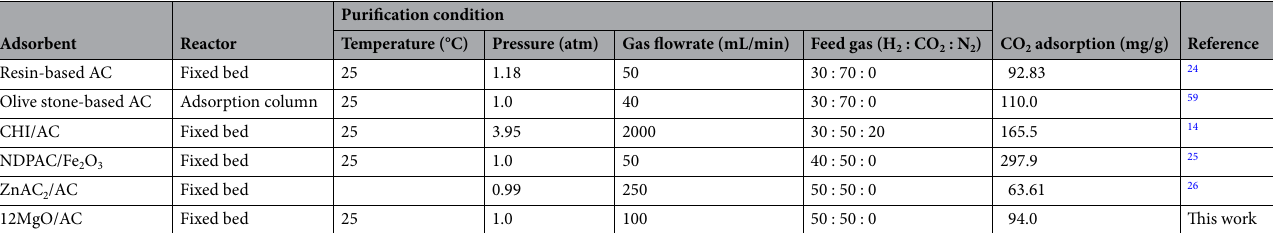
Table 2. Comparative biohydrogen purification by adsorption